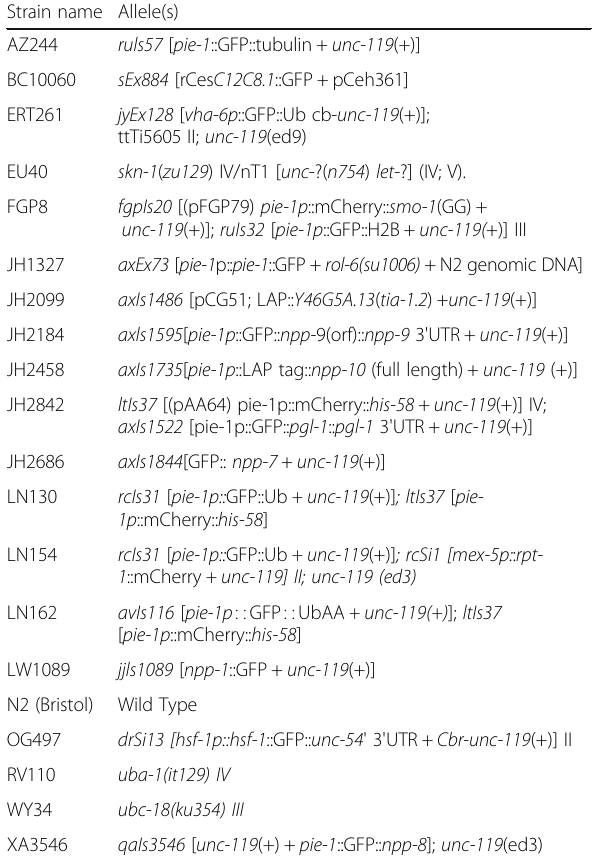
Table 1 C. elegans strains used in the